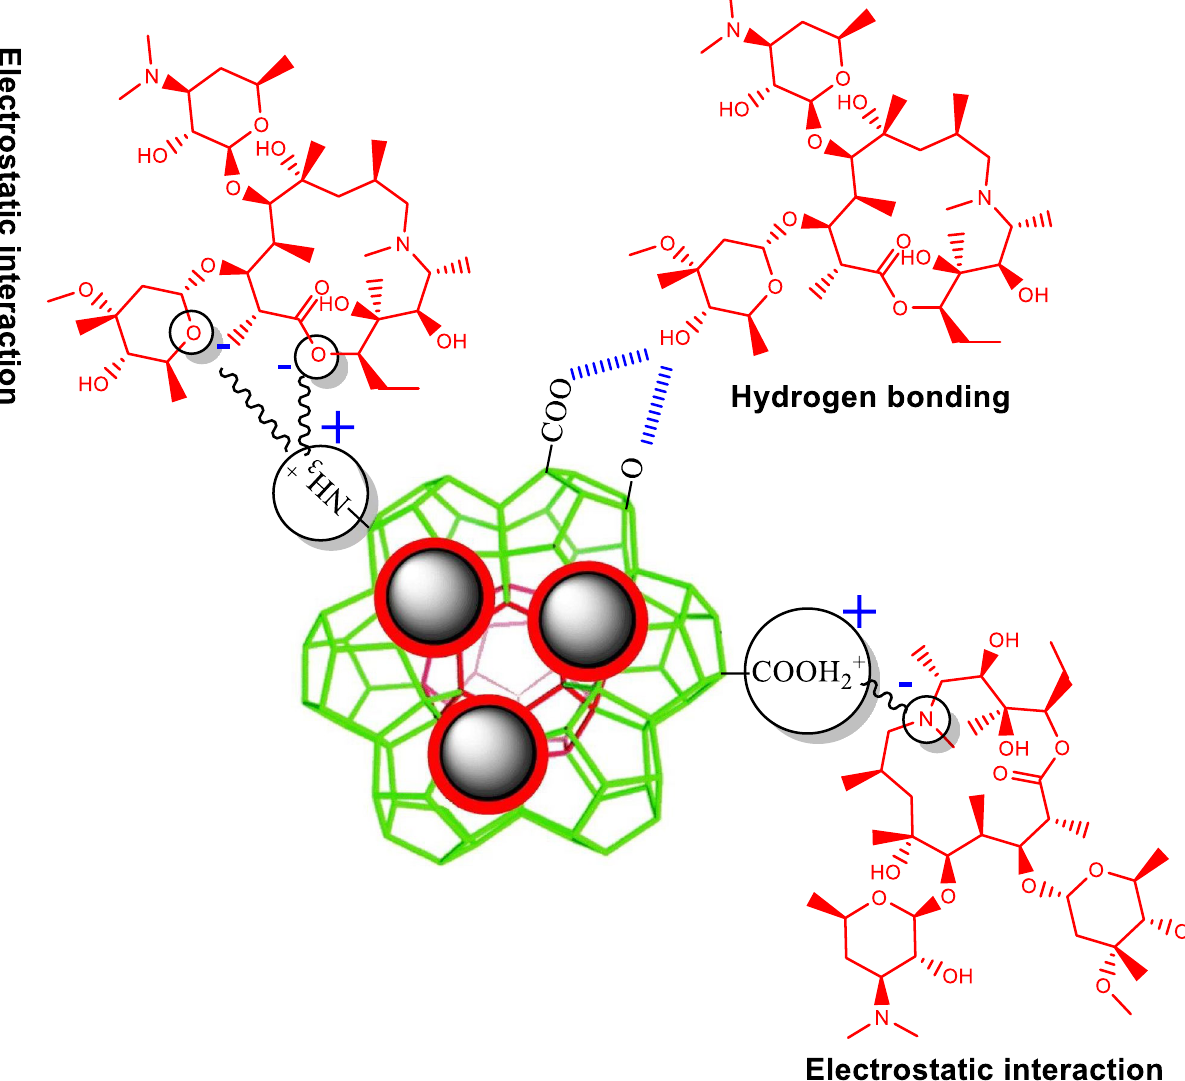
Figure 6. Possible mechanism of AZM adsorption on MIL/Cs@Fe 3 O 4 NCs.